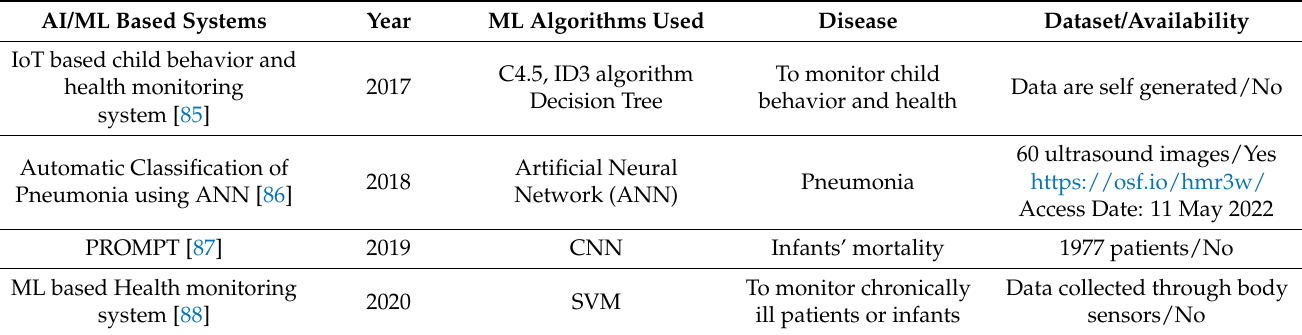
Table 5. AI/ML techniques used in infant healthcare